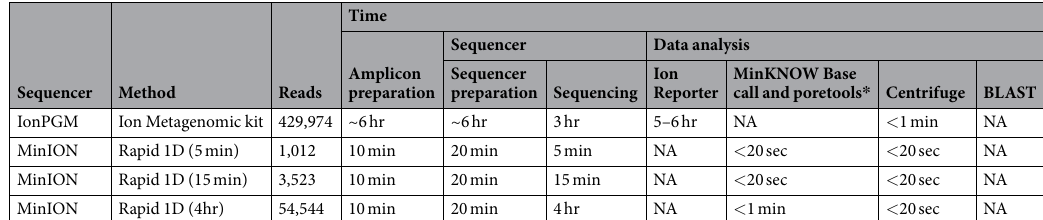
Table 2. Time scale for the pleural effusion sample sequencing. * Base-calling was performed simultaneously while sequencing using MinKNOW